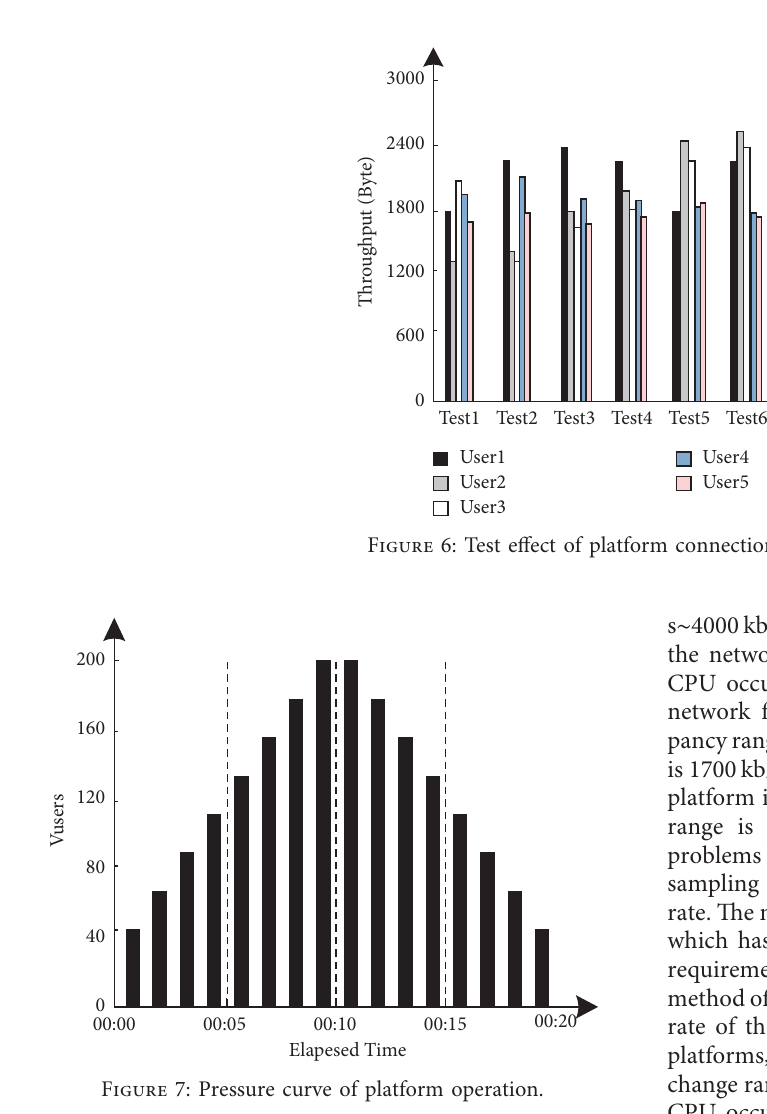
Figure 5: Results of innovation and entrepreneurship information mining: (a) time amplitude; (b) frequency amplitude.